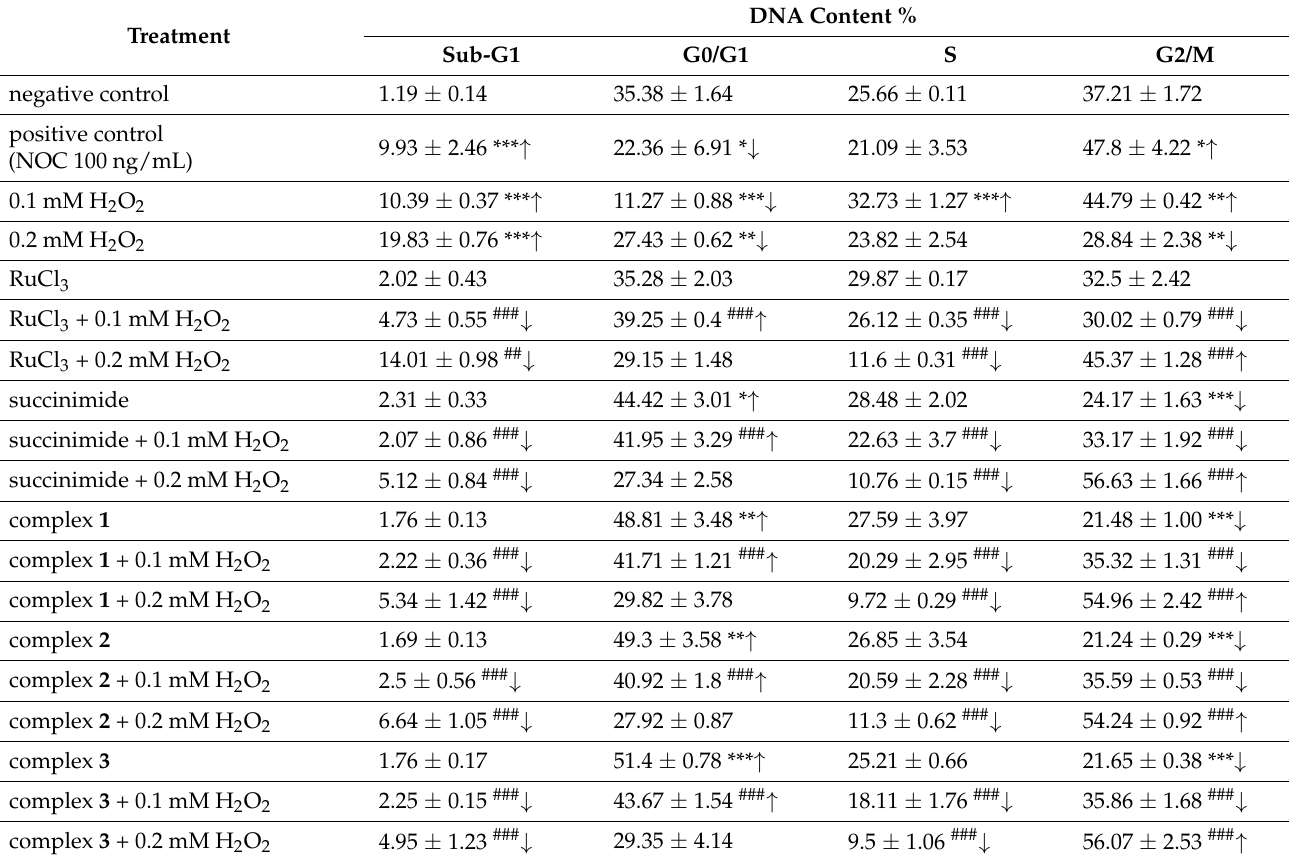
Table 1. Cell cycle distribution measured by flow cytometry using a staining with propidium iodide in HL-60 cells pre-incubated for 24 h at 37 ◦ C with ruthenium complexes 1 – 3 at 50 µ M and then incubated with H 2 O 2 at 0.1 and 0.2 mM for 24 h at 37 ◦ C. The cells incubated with 100 ng/mL nocodazole (NOC) for 24 h at 37 ◦ C were the positive control. DNA Content